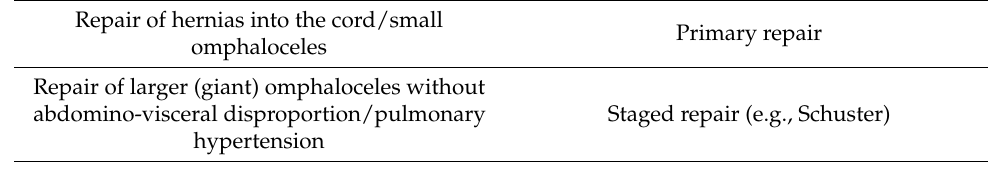
Table 3. Omphalocele